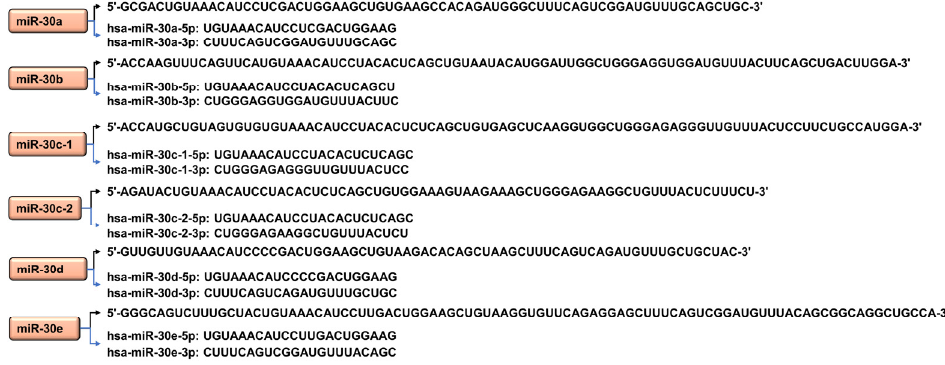
Figure 2. Sequences of pre-miR (black arrow) and mature miR (blue arrow) of the miR-30 family. miR-30c is also named miR-30c-5p in the literature, and miR-30c-1-5p and miR-30c-2-5p share the same mature miRNA sequence.